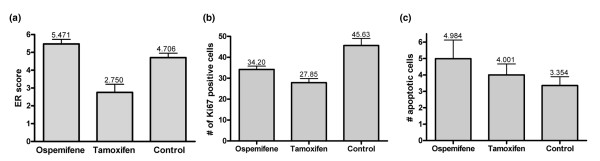
Immunohistochemistry analysis of mammary intraepithelial neoplasia outgrowths (MIN-Os) treated with selective estrogen receptor modulator (SERM). (a) Estrogen receptor (ER)-positive status was assessed by immunohistochemisty. ER positivity was slightly increased in ospemifene-treated MIN-Os (P < 0.05) and significantly decreased by tamoxifen treatment (P = 0.0005). (b) The cell proliferation rate in SERM-treated MIN-Os was assessed by counting nuclei positive for the proliferation marker Ki-67 in a 40× field. Cell proliferation was in general decreased by the SERM treatments (P < 0.05 for ospemifene and P < 0.01 for tamoxifen). (c) SERM treatments slightly increased the averaged apoptotic cell number in the MIN-Os but the differences were not statistically significant (P = 0.198 for ospemifene and P = 0.4768 for tamoxifen).